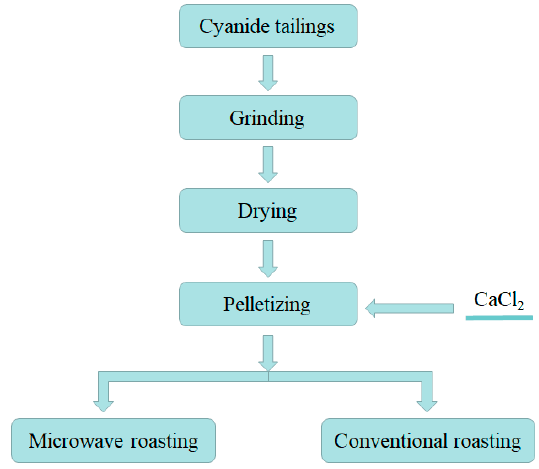
Figure 3. Cyanide tailings gold extraction process.